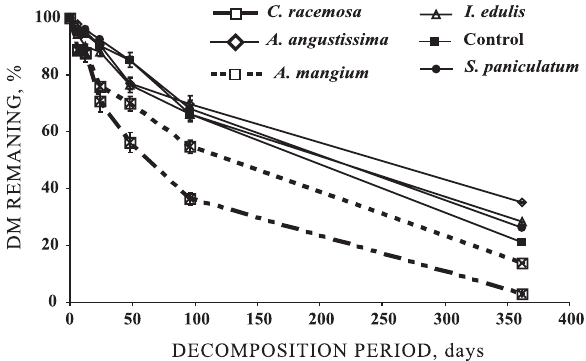
Figure 1. Remaining dry mater (DM) in litter bags of residues of five leguminous species and fallow vegetation (control) during decomposition period. Bars represent stand